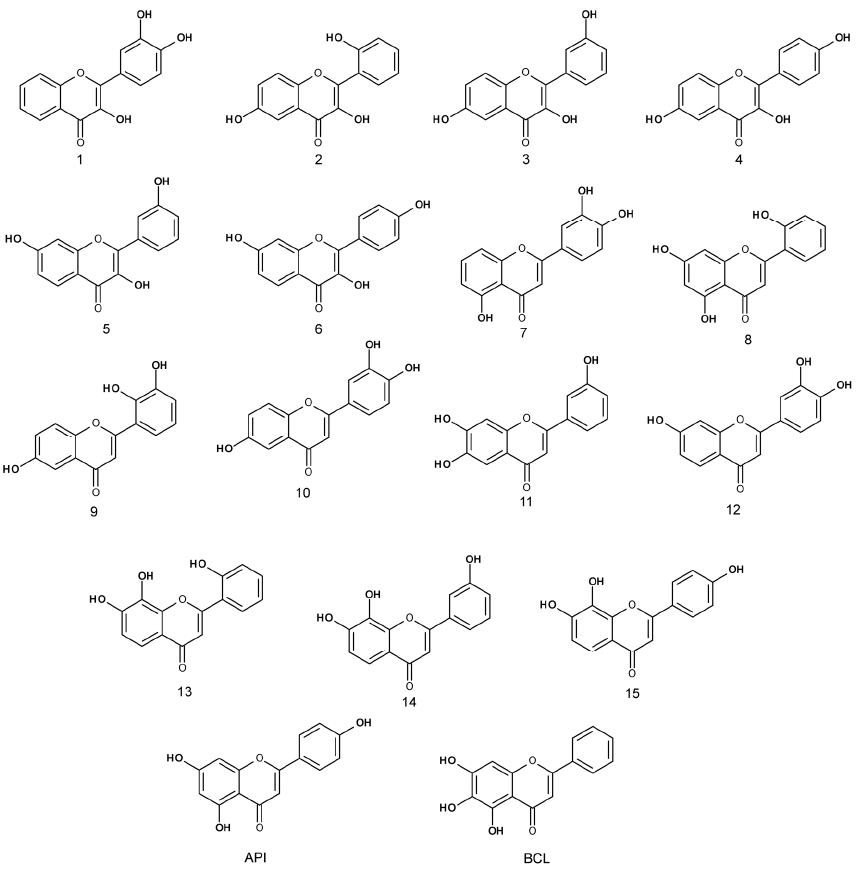
Figure 2. Chemical structures of tested trihydroxyflavones.